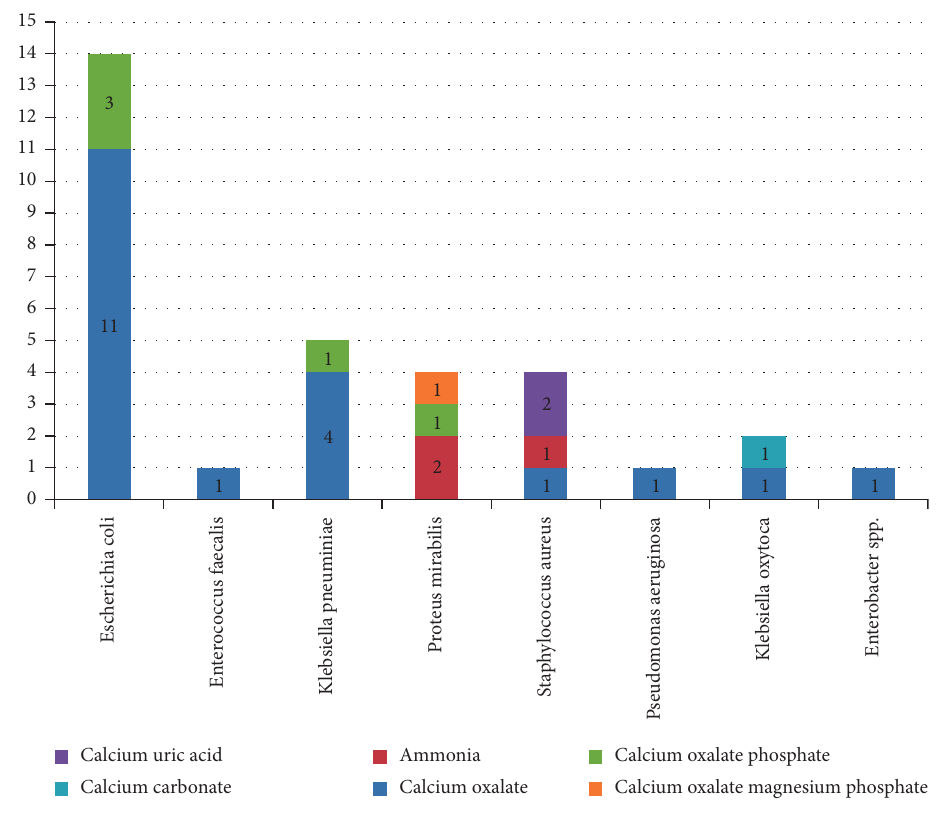
Figure 3: Stone bacteria with stone